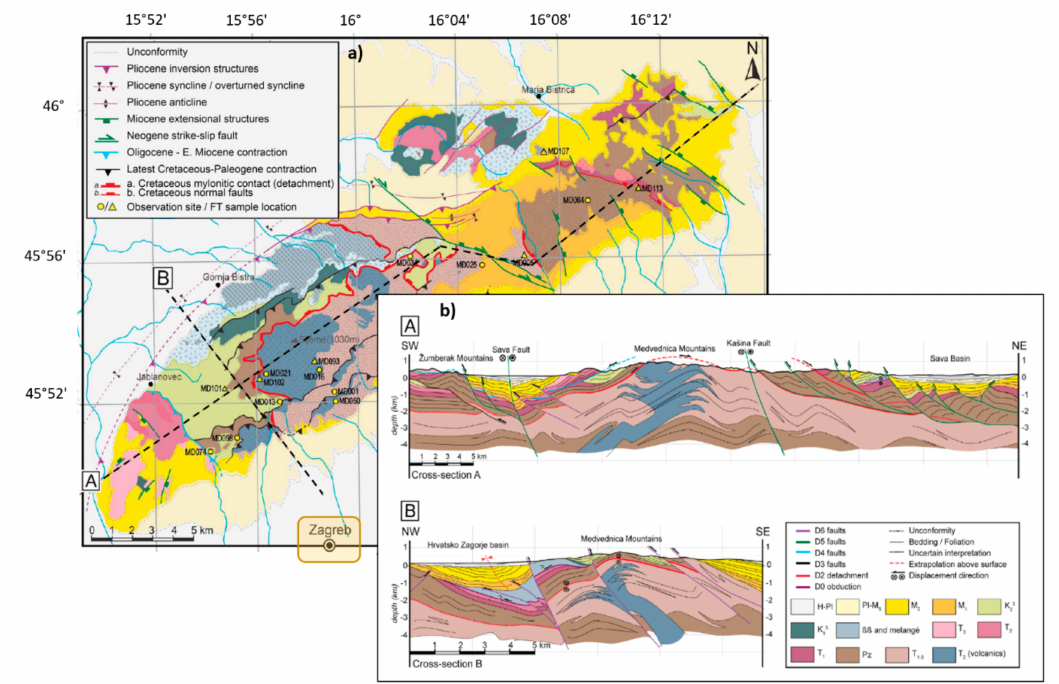
Figure 1. ( a ) Geological map of the Medvednica Mountains. The map shows the location of the cross-sections A and B; ( b ) Cross-sections across the Medvednica Mountains: (A) longitudinal (SW–NE) and (B) transversal (NW–SE) (after